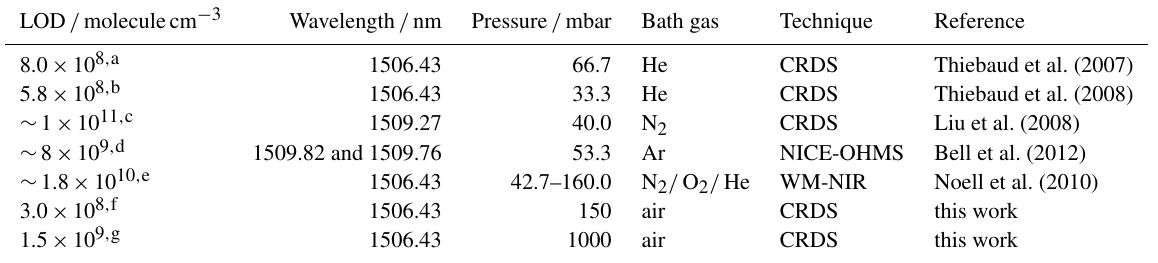
Table 2. Comparison of the detection limits (LOD) for HO 2 obtained in this work with previously reported LOD (extrapolated to 30 s integration time, 0.033 Hz detection bandwidth) obtained by detecting HO 2 in near IR via the first vibrational overtone of the O-H stretch.